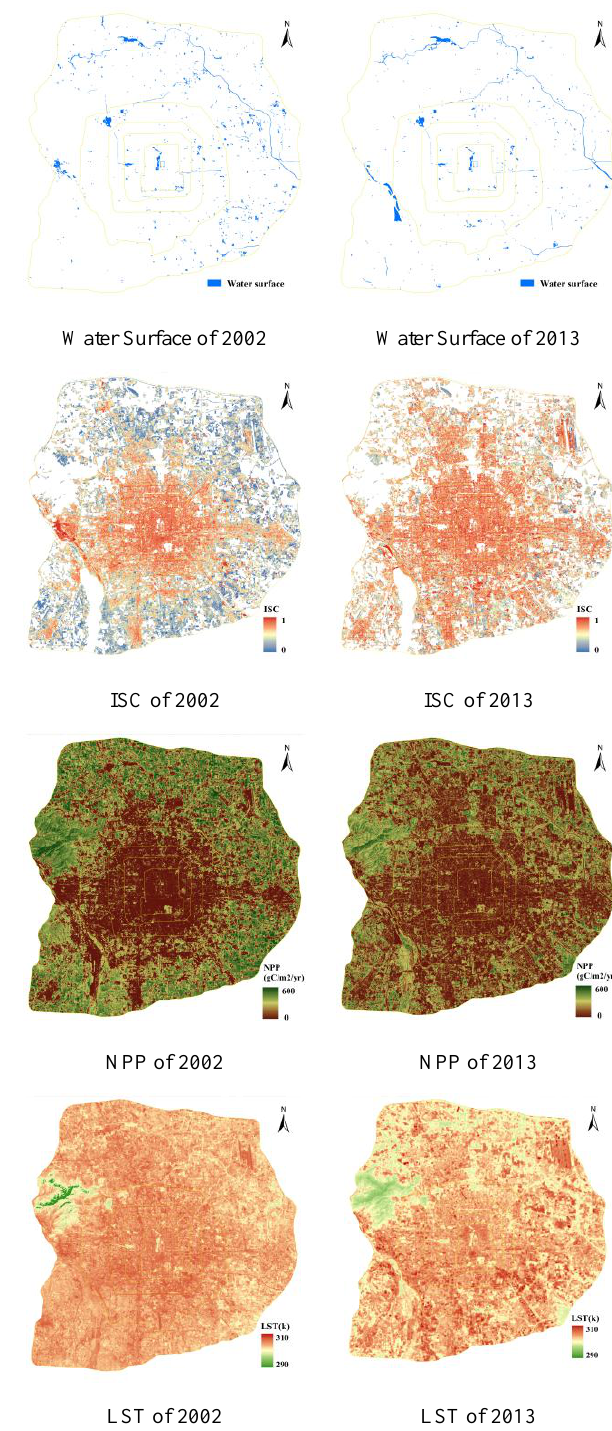
Figure 3. Spatial pattern of ecological environment indicators inside of Beijing 6 th Ring Road Inside of 2 nd Ring Road, FVC, WD, ISC, NPP, and LST changed towards a better result. In 2 nd to 3 rd Ring Road and 3 rd to 4 th Ring Road, FVC, NPP, and LST changed towards a better result. In 4 th to 5 th Ring Road, FVC and LST changed towards a better result. In 5 th to 6 th Ring Road, only LST changed towards a better result. FVC changed toward a better result inside of 5 th Ring Road. NPP changed toward a better result inside of 3